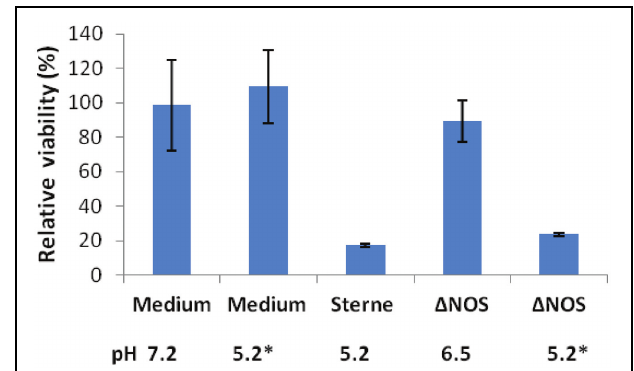
FIGURE 2 | Cytotoxic effect of Sterne and (cid:2) NOS static culture sups. Bacteria were grown in DMEM (10 ml, 24 h, 37 ◦ C, 5% CO 2 ) in static conditions and the culture sups were prepared. The monolayers of human small-airway lung epithelial cells (HSAECs) were exposed to the bacterial sups for 2 h and the viability of the cells was determined using Resazurin dye as described in Section “Materials and Methods”. The final pH values of the sups and control medium are shown. Asterisks indicate the sups titrated to the pH 5.2 of Sterne sup after cultivation. The error bars indicate 95% confidence intervals of triplicate